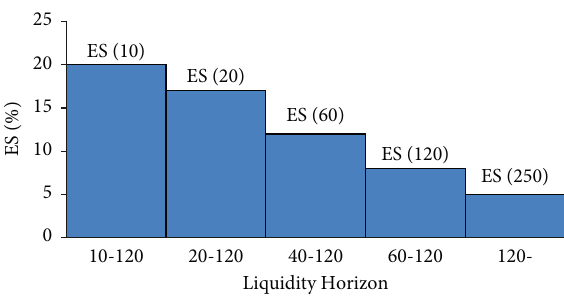
Figure 1: Te expected shortfall (ES) calculation.